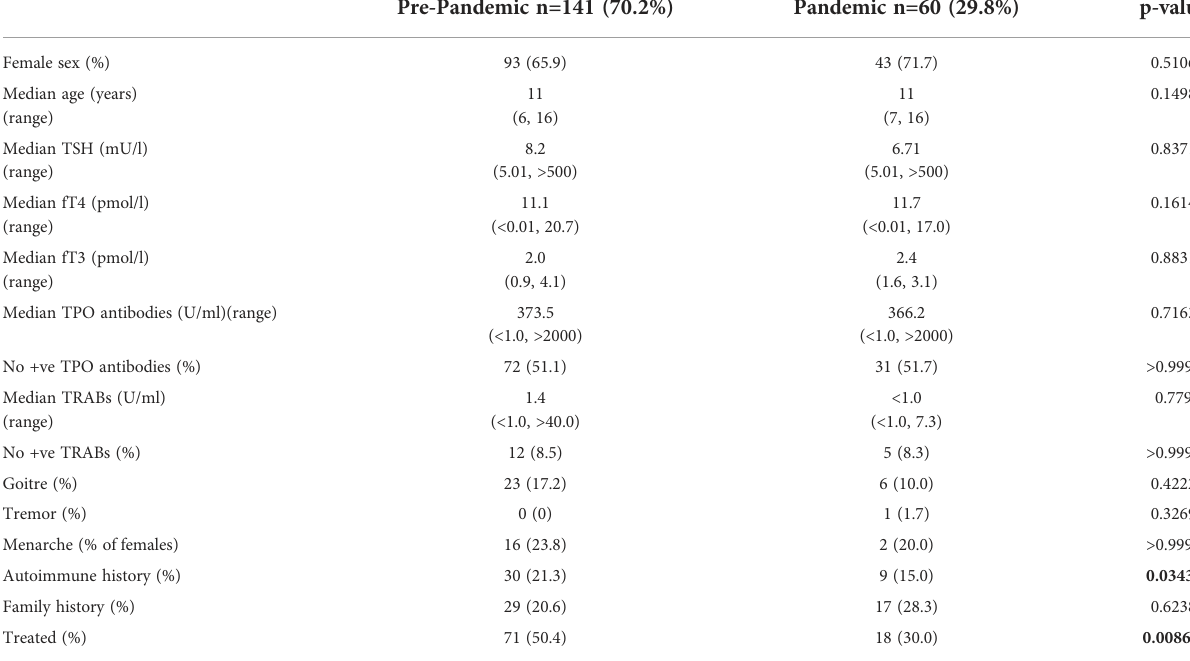
TABLE 2 Characteristics of hypothyroid patients (n=201) prior to the pandemic and during the